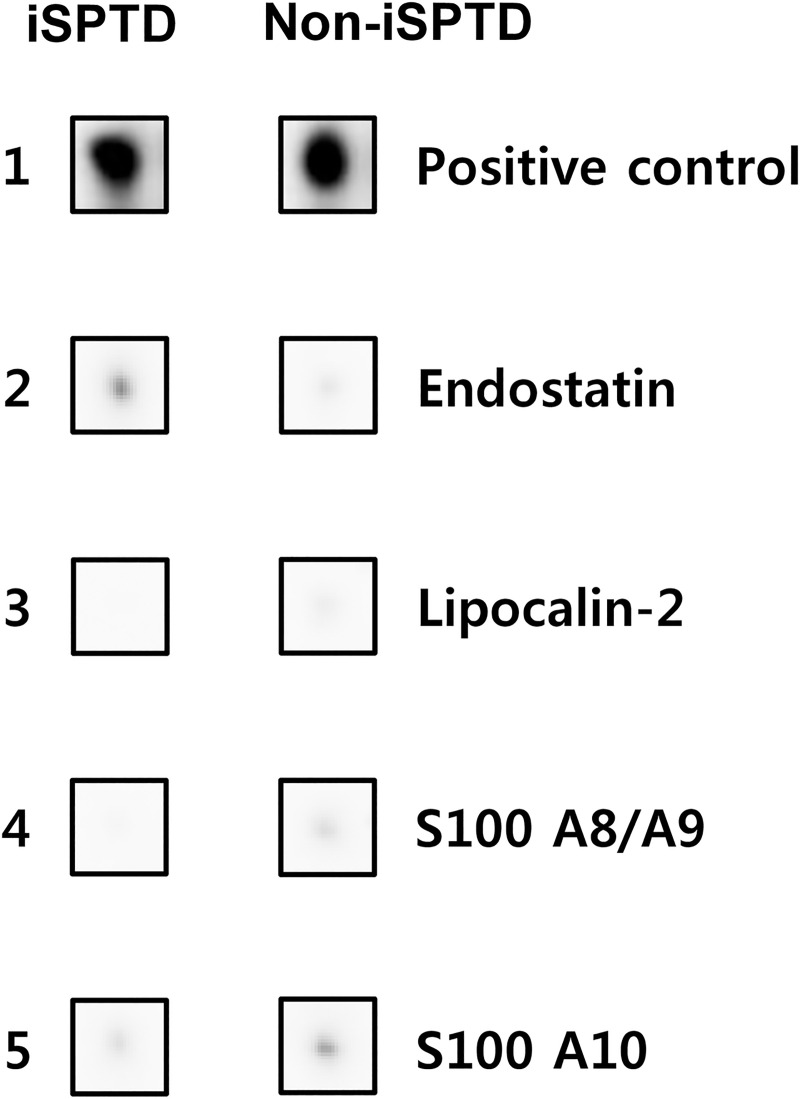
List of 4 proteins with significantly differential expression between the amniotic fluid (AF) from women with preterm premature rupture of membranes (PPROM), who had subsequent spontaneous preterm delivery (SPTD) within 14 days of sampling and AF from PPROM women delivering after 14 days, using the criteria of a ≥ 1.5-fold change or a ≤ 0.66-fold change in signal intensity.iSPTD, imminent spontaneous preterm delivery.